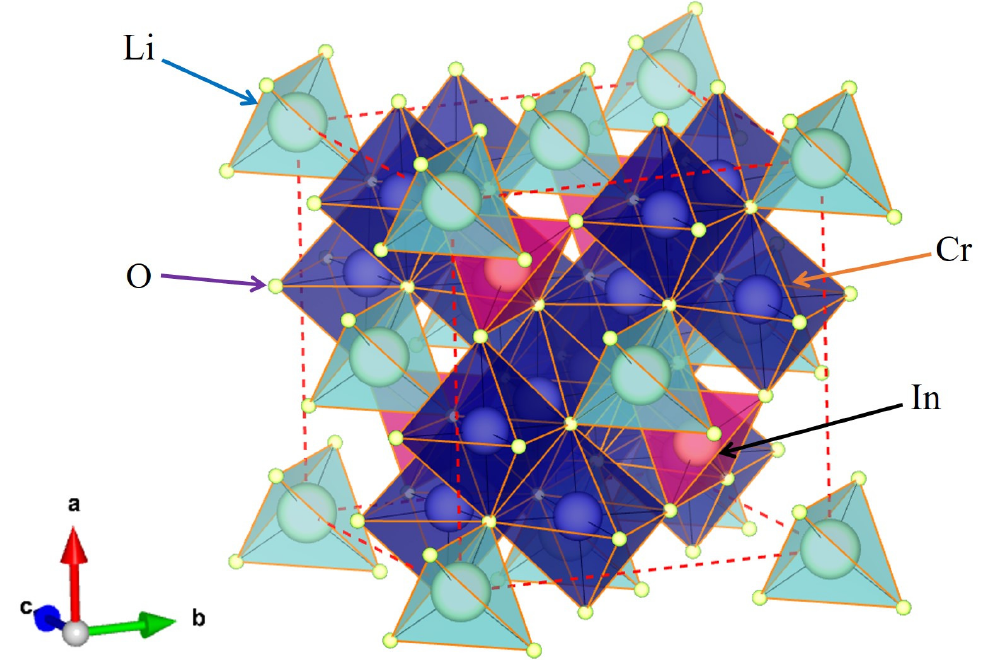
Figure 1. Sketch of the breathing chromium spinel LiInCr 4 O 8 crystal structure with LiO 4 and InO 4 tetrahedra and CrO 6 octahedra as structural